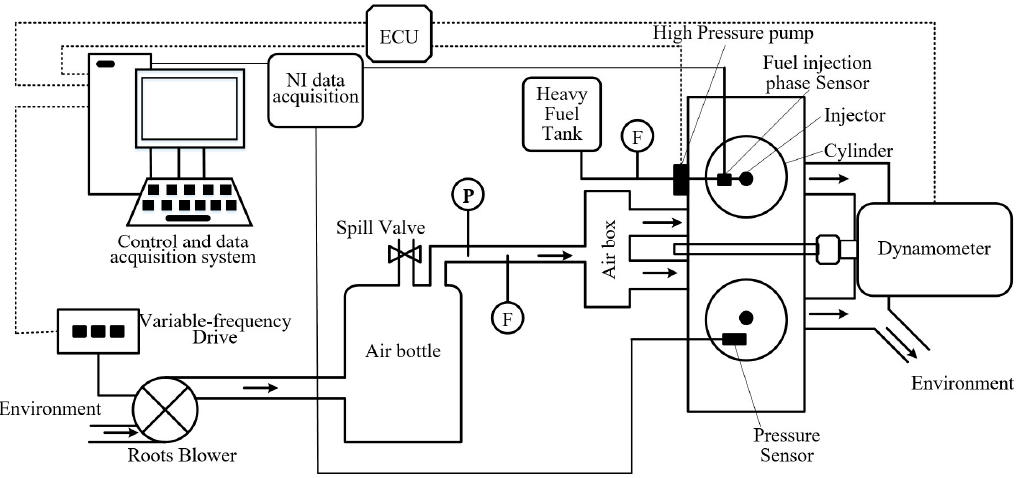
Figure 2. Schematic diagram of the experimental system.